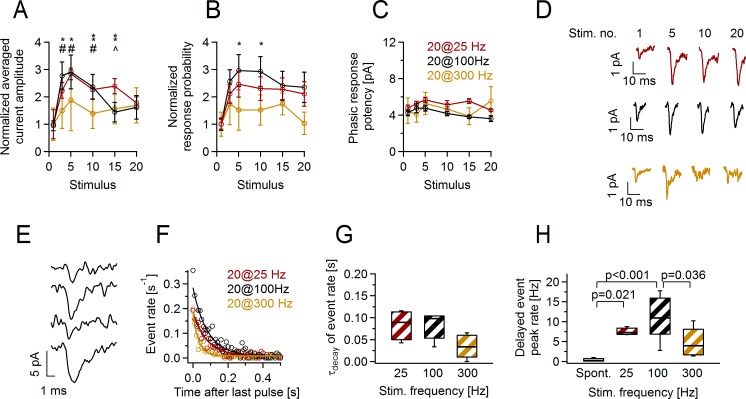
Activity-dependent changes at axon-oligodendrocyte precursor cell (OPC) synapses are determined by the stimulation paradigm also in the adult (P50–53) mice.(A–C) Normalized average (A) current amplitude including failures, (B) probability of responses, and (C) absolute potency of responses upon each stimulus of the minimal stimulation train of 20 pulses at 25 Hz (n = 4 cells), 100 Hz (n = 6 cells), or 300 Hz (n = 5 cells). One-way ANOVA (S11 Data). 25 Hz versus 300 Hz stimulation: *p < 0.05, **0.001 < p < 0.01. 100 Hz versus 300 Hz stimulation: #p < 0.05. 25 Hz versus 100 Hz stimulation: ^p < 0.05 (D) Example traces showing average currents (including failures) in 3 OPCs in response to the 1st, 5th, 10th, and 20th stimulus of the minimal stimulation train of 20 pulses at 25 Hz, 100 Hz, and 300 Hz. At least 15 trials were averaged to generate each example trace. (E) Original example traces showing delayed currents in callosal OPC (holding potential [Vh] = −80 mV) occurring after the stimulation train of 20 pulses at 25 Hz. (F) Average rate of delayed currents occurring after the stimulation train of 20 pulses at 25 Hz, 100 Hz, or 300 Hz. Solid lines indicate monoexponential fits to the events rate. (G) Average decay time constants of the delayed event rate after the stimulation train with 20 pulses at 25 Hz, 100 Hz, or 300 Hz. One-way ANOVA (S11 Data). (H) Average peak rate of the delayed events after the stimulation with 20 pulses at 25 Hz, 100 Hz, or 300 Hz. The box “Spont.” shows the frequency of the spontaneous events recorded before each stimulation train. One-way ANOVA (S11 Data). Box and whisker plots: the bottom and top of each box represent 25th and 75th percentiles of the data, respectively, while whiskers represent 10th and 90th percentiles. The midline represents the median. The numerical data used in A–C and G–H are included in S12 Data.